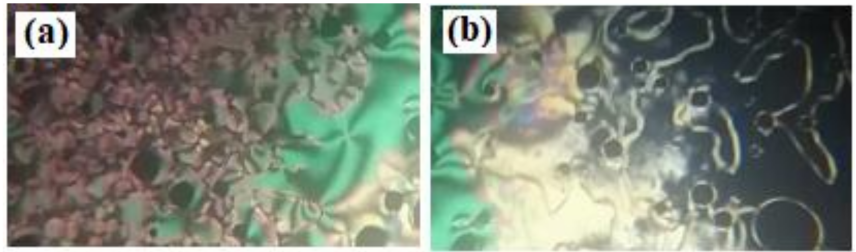
Figure 2. POM images of N mesophase upon heating of compound A8 at ( a ) 158.0 ◦ C and ( b ) 172.0 ◦